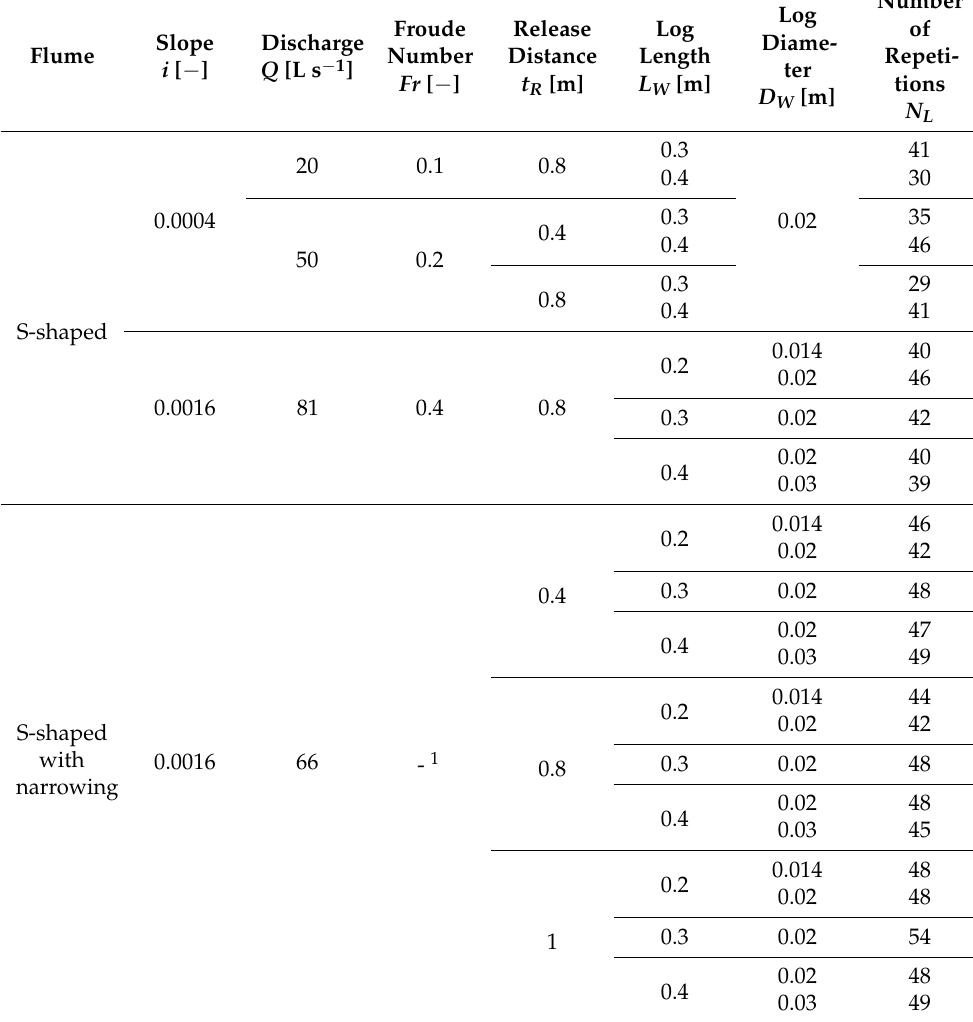
Table 1. Summary of the main parameters of the experiments.